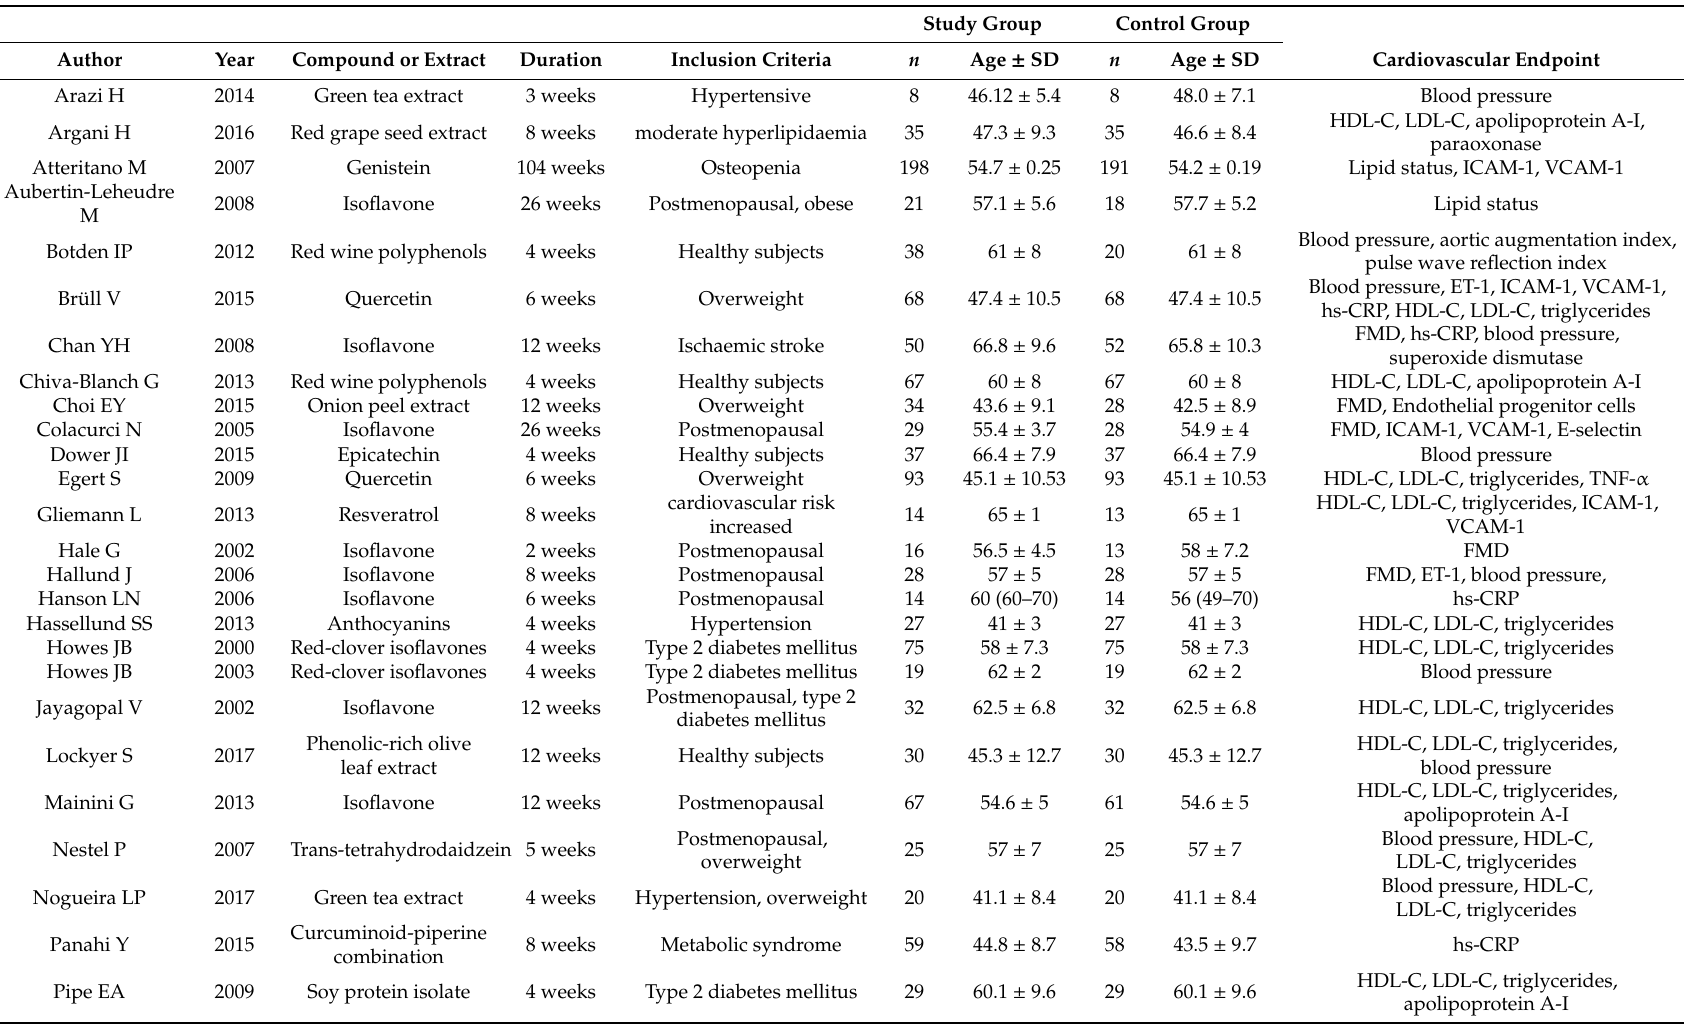
Table 1. Study characteristics after search for cardiovascular e ff